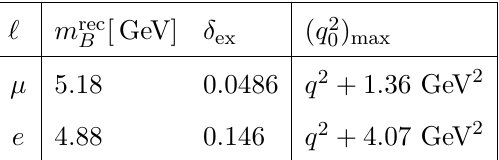
Table 1 . Relation between the cut on the reconstructed mass m rec affecting the spectrum at a given q 2 -value, after photon radiation, according to (4.1). The specific values of m rec are fixed to the same values used in the LHCb analysis of R B